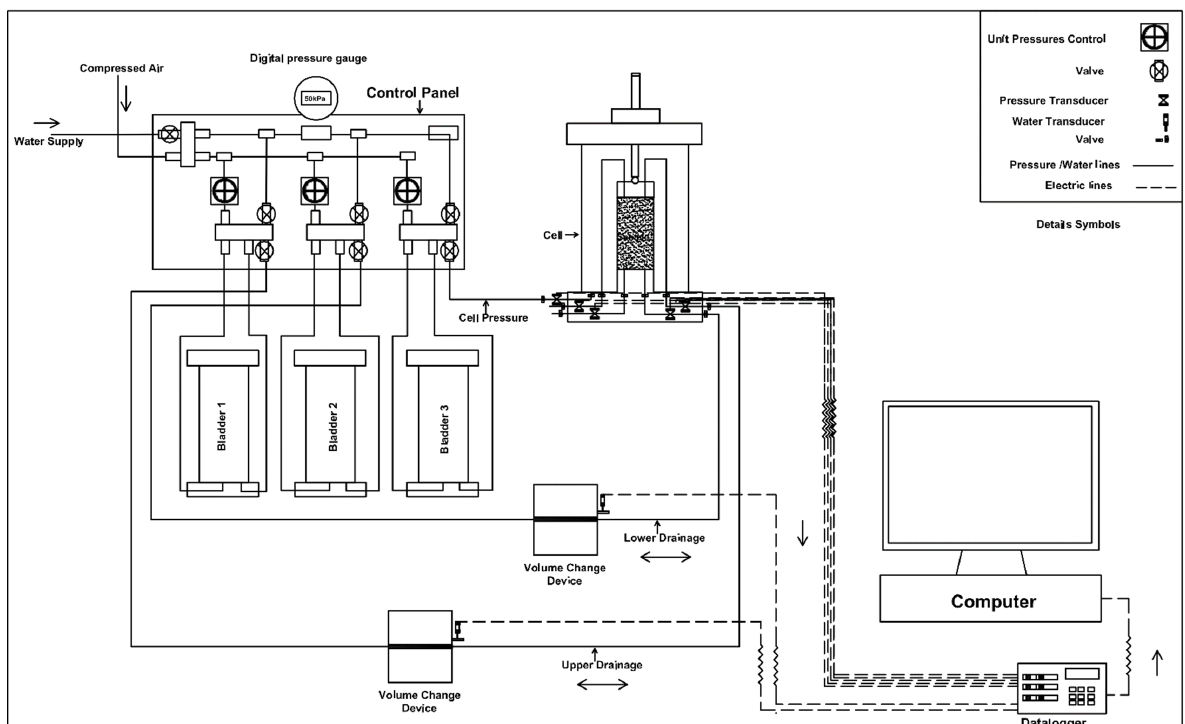
Figure 2. Schematic diagram of a flexible wall permeameter (after [32]).